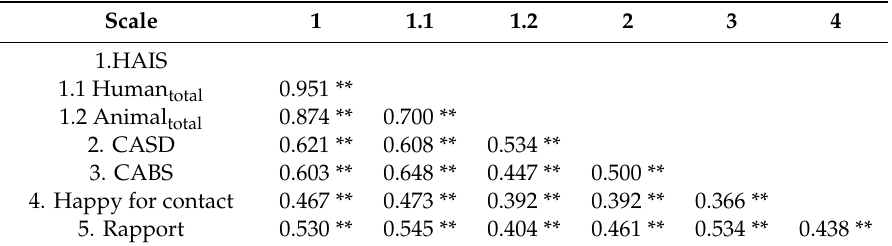
Table 3. Correlations between scales in non-clinical volunteers (n =